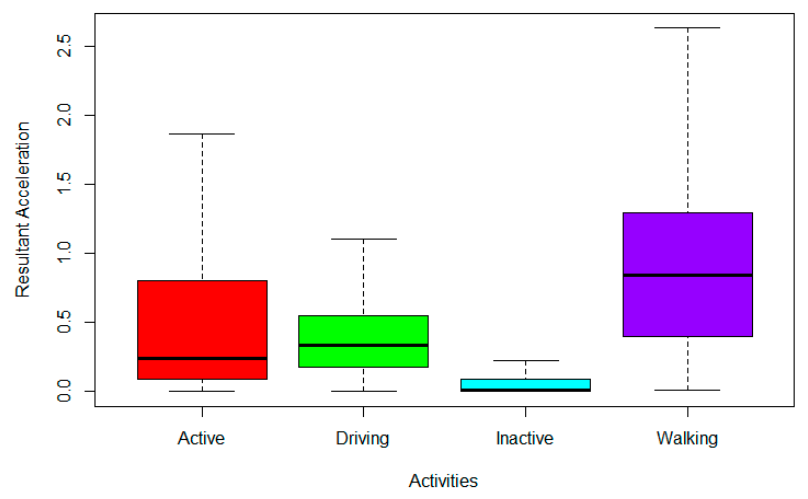
Figure 3. Removal of Outliers.